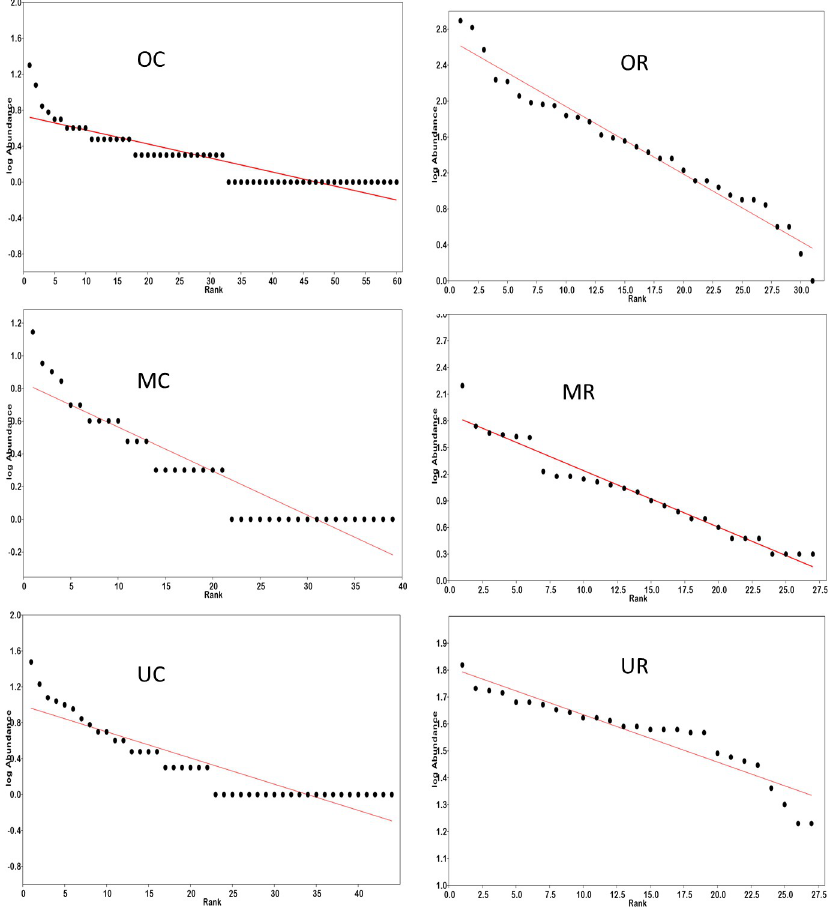
Fig 5. Rank-abundance geometric series curves (models) applied to overstorey, midstorey, and understorey flora species in the reclaimed and control sites. Figures OC–overstorey control, OR–overstorey on reclaimed sites, MC– midstorey on control site, MR–midstorey on reclaimed site, UC–understorey on control site, and UR–understorey on reclaimed sites.